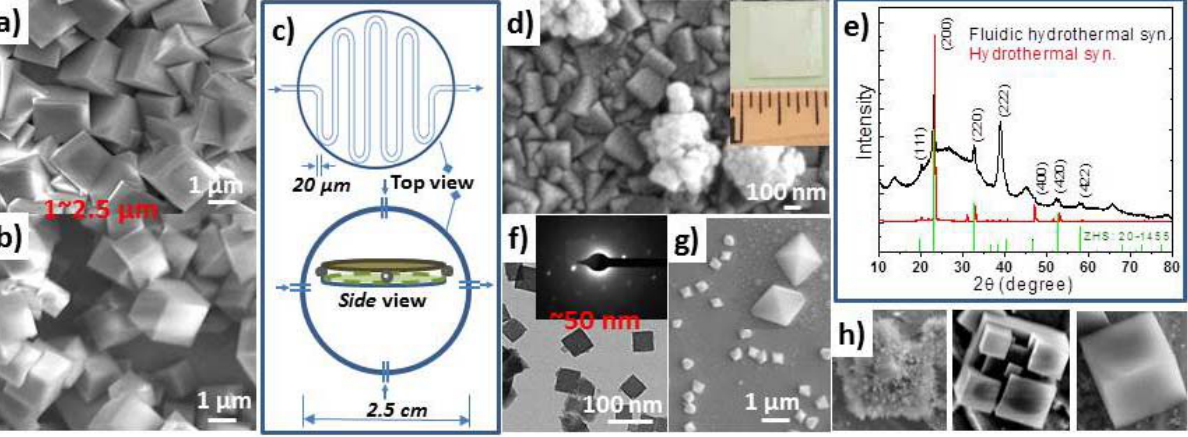
Figure 16. Single crystalline ZHS cubes grown on pure tin substrate ( a ) and ITO/quartz substrate ( b ) via a seedless static hydrothermal synthesis method; ( c ) A typical 1” fluidic cells introduced to the conventional hydrothermal method for improving the yield and uniformity of ZHS cube films. ( d ) Continuous ZHS cube films on ITO/quartz by fluidic synthesis, inset: 1 cm by 1 cm ZHS coated slide. ( e ) Multiple-facet ZHS nanoparticle films grown by fluidic synthesis versus {200}-facet ZHS cube film from conventional hydrothermal method, revealed by their corresponding XRD spectra. ( f – h ) Nanosized and different morphological ZHS cubes obtained by fluidic hydrothermal